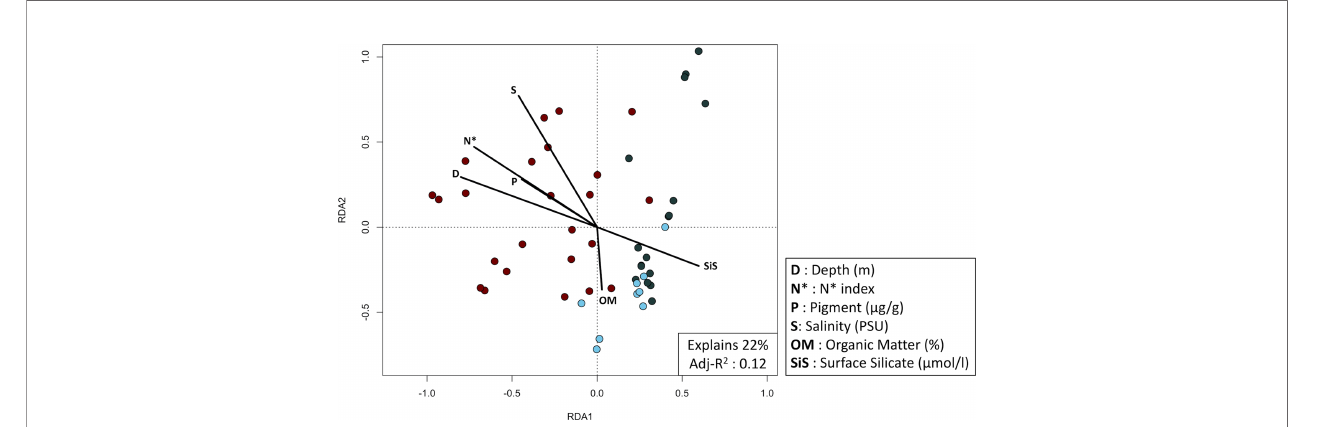
FIGURE 8 | Redundancy analysis plot of the biomass Hellinger transformed 50 epifaunal stations sampled between 2010 and 2018 (p-value = 0.0001). Signi fi cant environmental variables were obtained using a two-step forward selection. Colors represent the community determined with a Bray-Curtis distance-based cluster analysis. Red dots are the stations from community 1, pale blues are community 2 and dark grays are